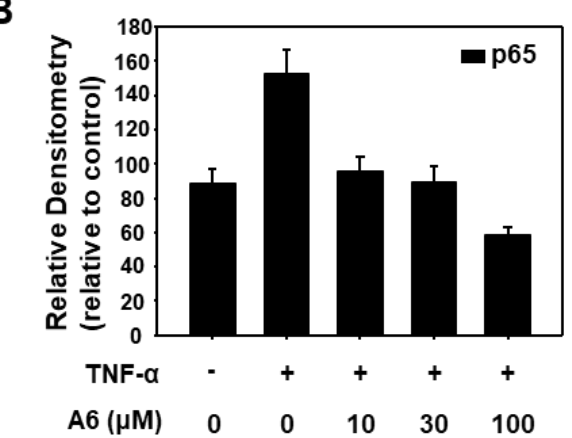
Table 4. In vivo anti-inflammatory activity of compounds 4a-i , 6a-k , and 8a-c administrated i.p.